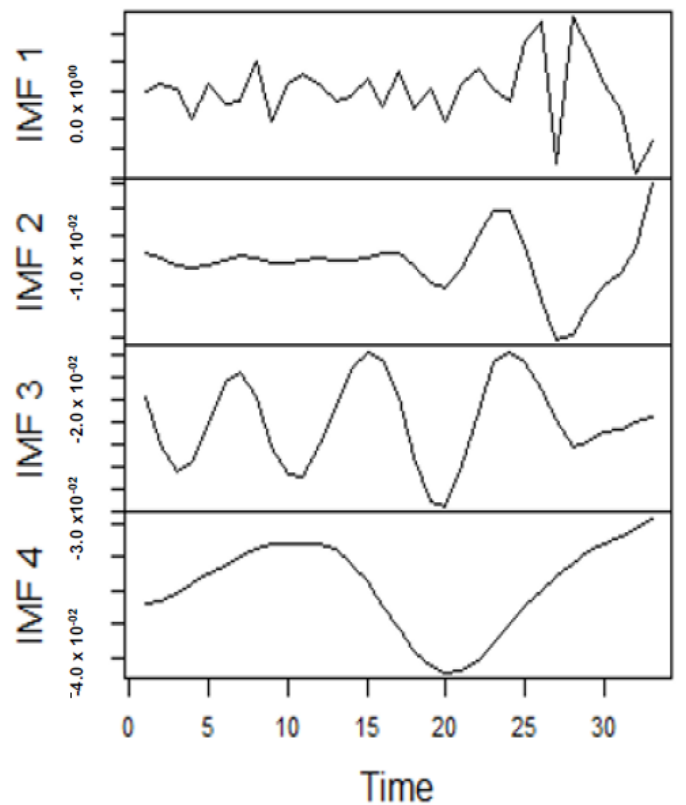
Figure 7. Part A: Part of the IMFs for Japan gas prices.